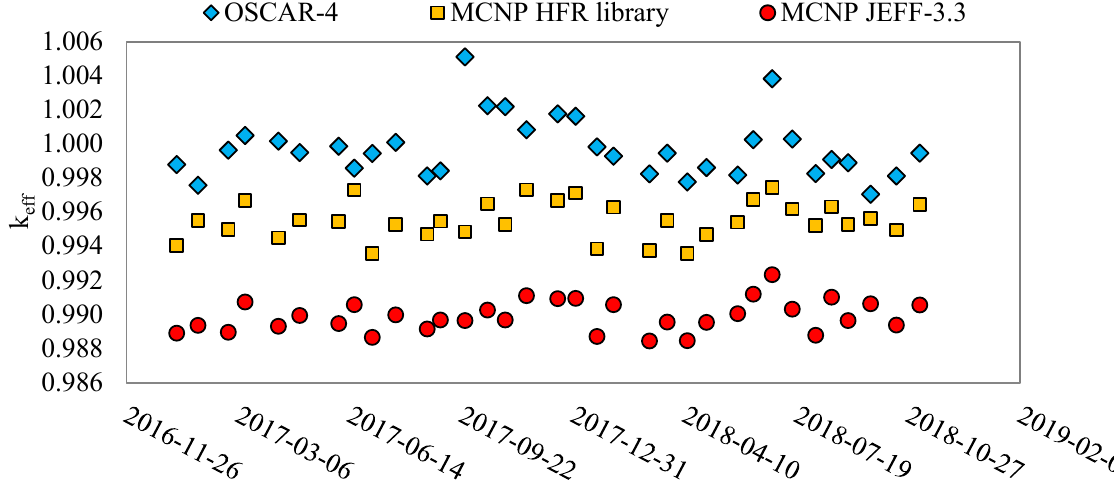
Figure 4. Calculated core reactivity comparison between OSCAR-4, MCNP with the HFR nuclear data library, and MCNP with the JEFF-3.3 nuclear data library for critical states in cycles 2017-01 to